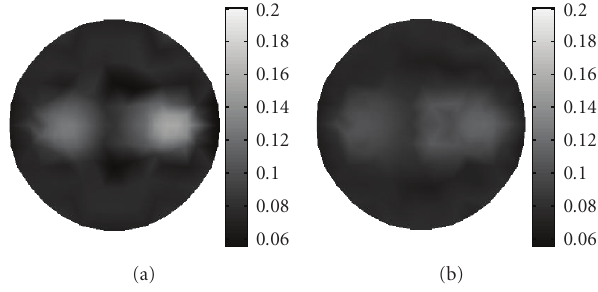
Figure 7: Reconstructed image of absorption coe ffi cient due to fluorophore μ axf based on adaptively refined mesh with (a) wavelet- based algorithm, and (b) single resolution method.